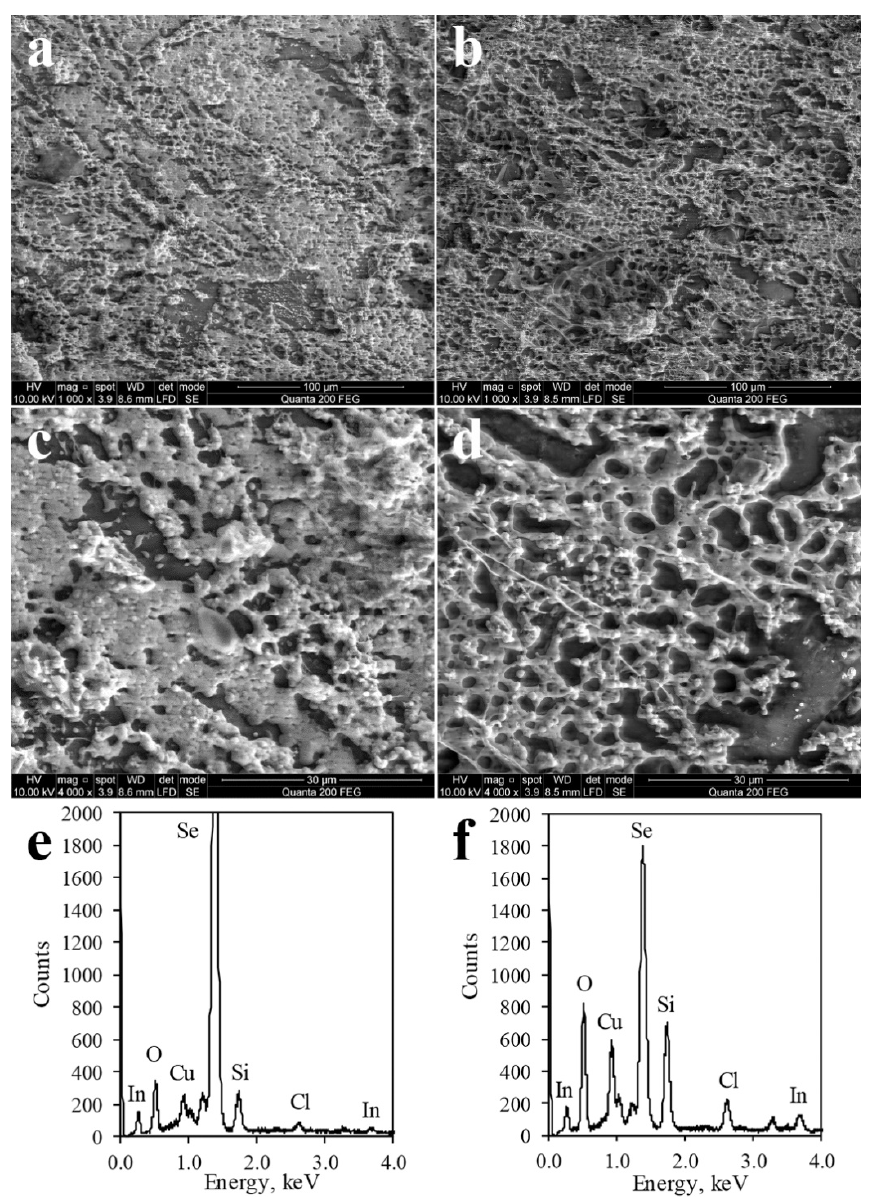
Figure 4. SEM images ( a – d ) and EDX spectra ( e , f ) of In-incorporated Cu x Se film on glass. SEM images are 4000 × ( a , c ) and 1000 × ( b , d ) magnifications. Treatment with copper(II/I) ion solution: ( a , c , e ) 10 min at 40 °C and ( b , d , f ) 10 min at 60 °C.